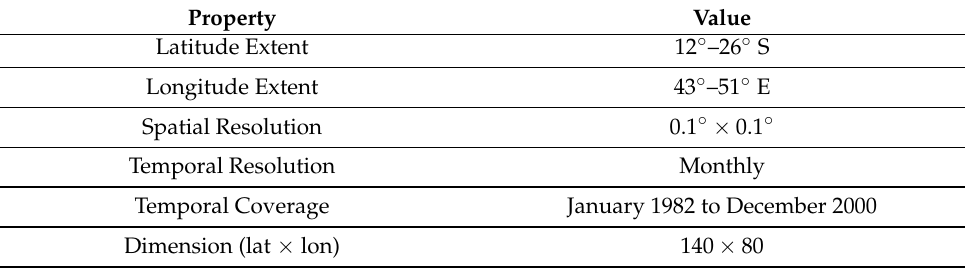
Table 1. Properties of Madagascar image data (extracted from FLDAS dataset).